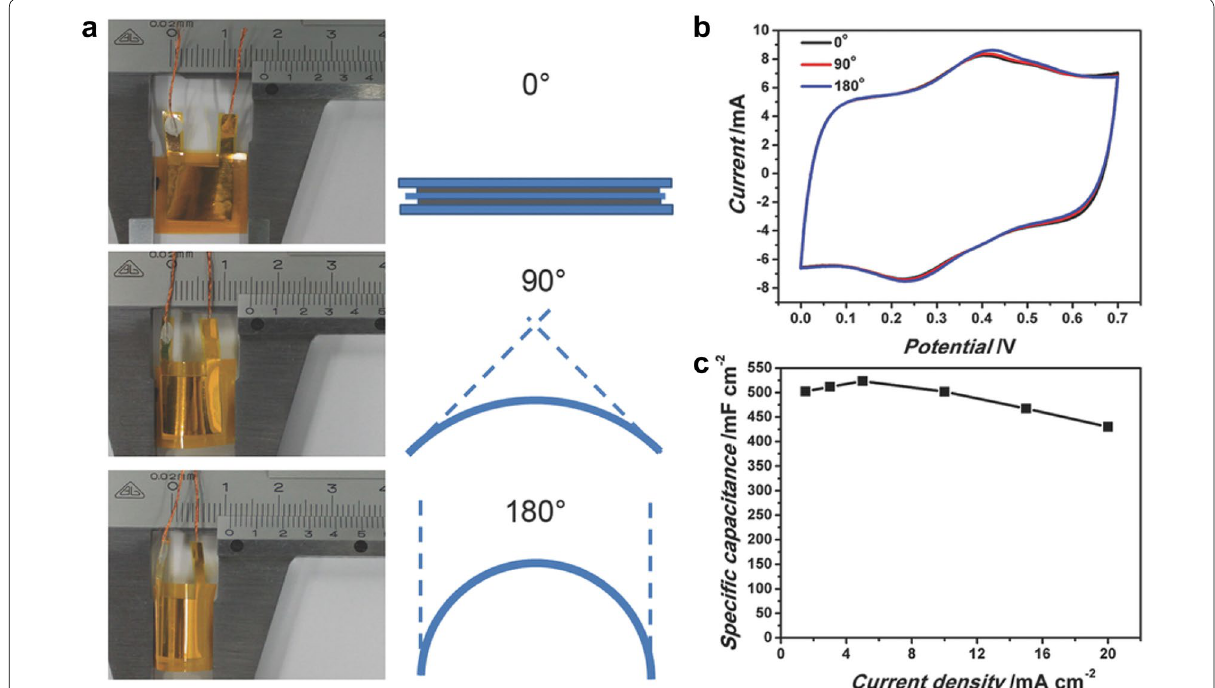
Fig. 8 a Images and schematics of a flexible film supercapacitor in different bending states. b CV curves of the film supercapacitor at scan rates of 20 mV/s when bent by 0°, 90°, 180°. c Area‑specific capacitance of the flexible film supercapacitor under different current densities (Reprinted with permission